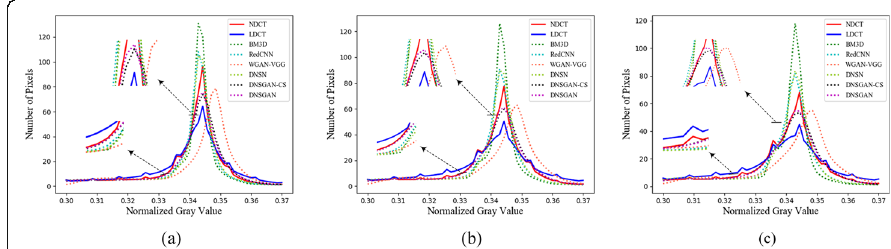
Fig. 9 The gray histogram statistic results of all the compared methods on the DGH dataset. ( a ), ( b ), and ( c ) separately denote result from the DGH-L, DGH-M, and DGH-H. Zoomed in for better